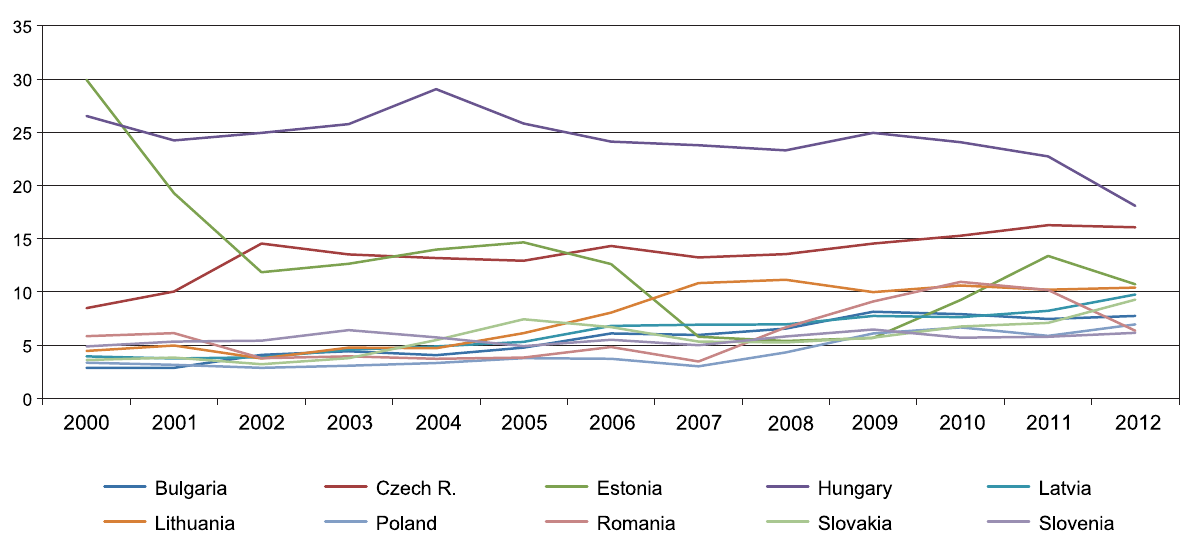
Fig. 4. High-tech products’ share in post-communist countries’ industrial exports, 2000–2012. Source: developed by the authors on the basis of the World Development Indicators data, the World